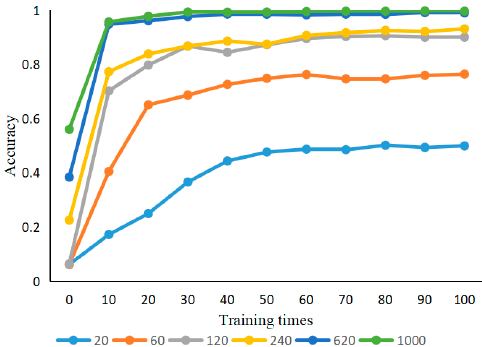
Figure 8. Results of experiments without transfer learning.